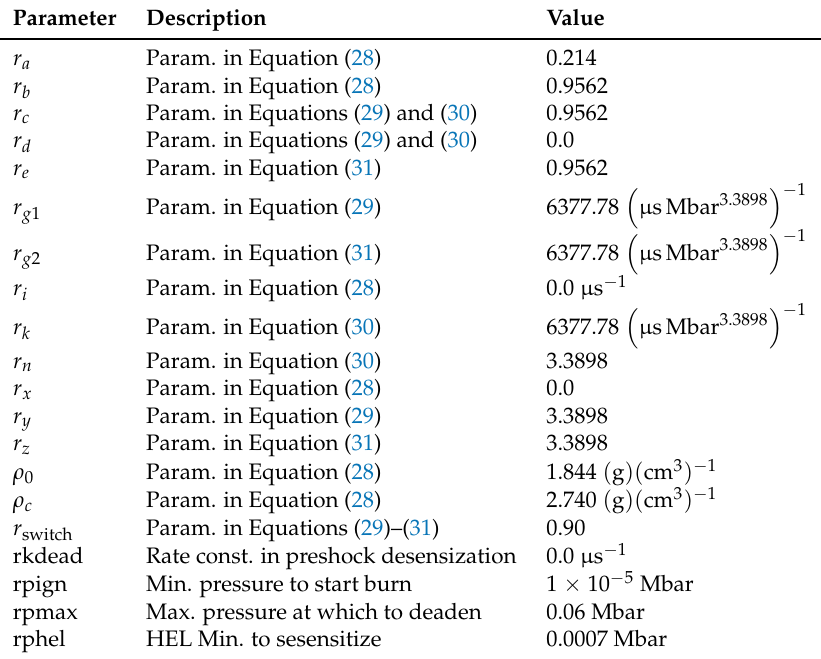
Table 4. Wescott–Stewart–Davis (WSD) parameter